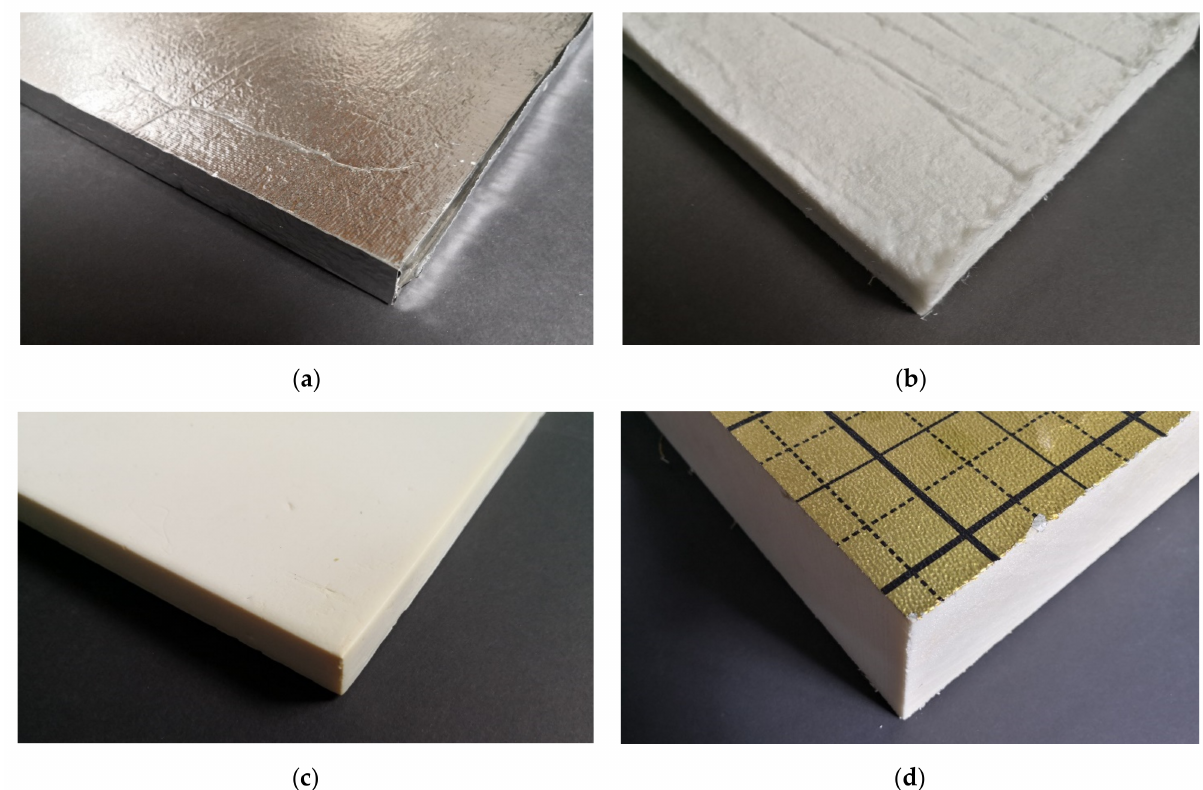
Figure 1. Thermal superinsulation materials considered for railway application: ( a ) vacuum insulation panel, ( b ) silica aerogel board, ( c ) polyurethane aerogel, ( d ) PIR board. Images: